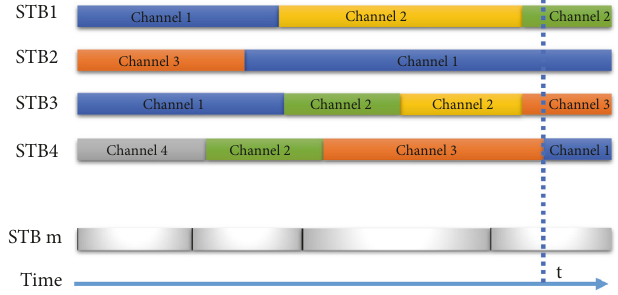
Figure 6: Example of TSTV